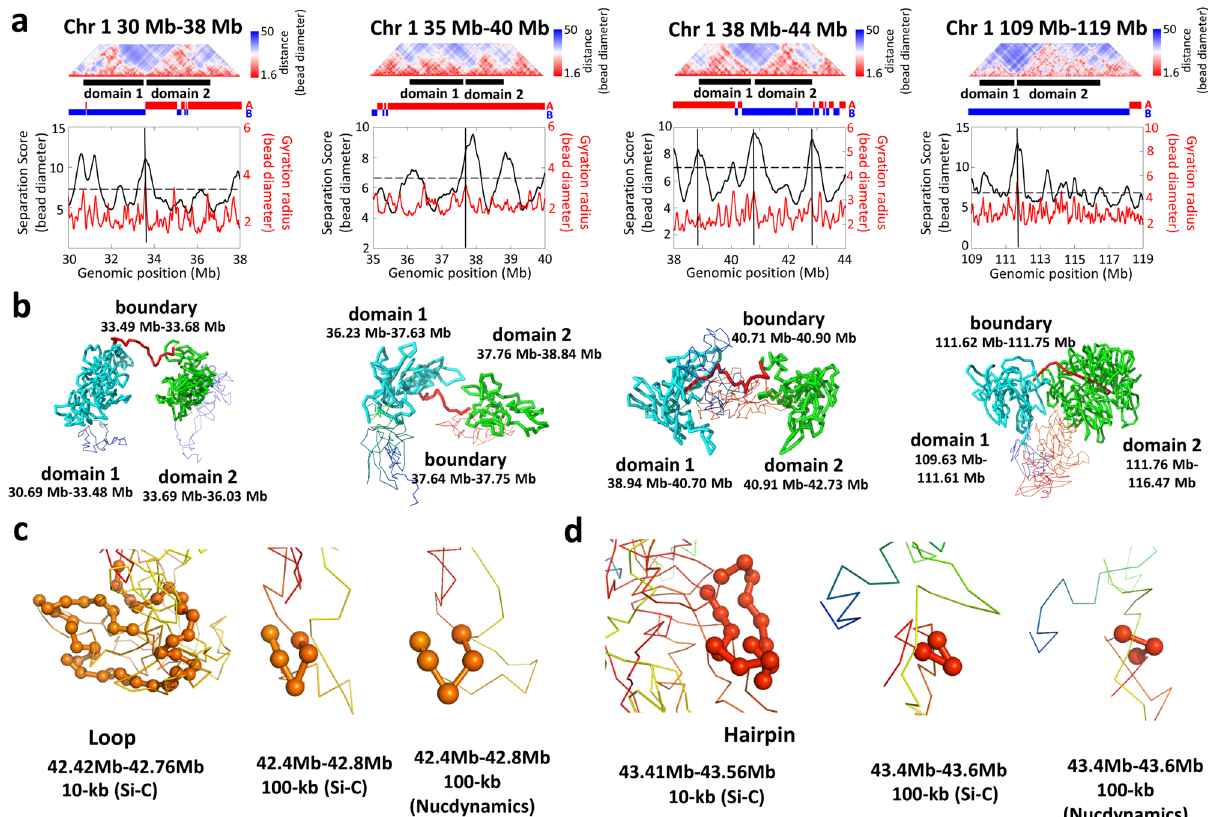
Fig. 5 Small-scale 3D structure at 10 kb resolution. a Top: heatmap plot of distance matrices derived from the Si-C 10 kb structure of cell 1 for four genomic regions. In each region, two neighboring domains that are identi fi ed by separation score are indicated by black lines. Bottom: distributions of the separation score and gyration radius ( R g ). b 3D structures of the genome regions associated with the two neighboring domains shown in ( a ). Structures corresponding to the boundary, domain 1 and domain 2 regions are shown in red, cyan, and green, respectively. c , d Loop and hairpin-like hyper fi ne structures visualized by beads of 10 kb size (left) and the 3D structures of the same regions visualized by beads of 100 kb size, inferred by Si-C (middle) and Nucdynamics(right).